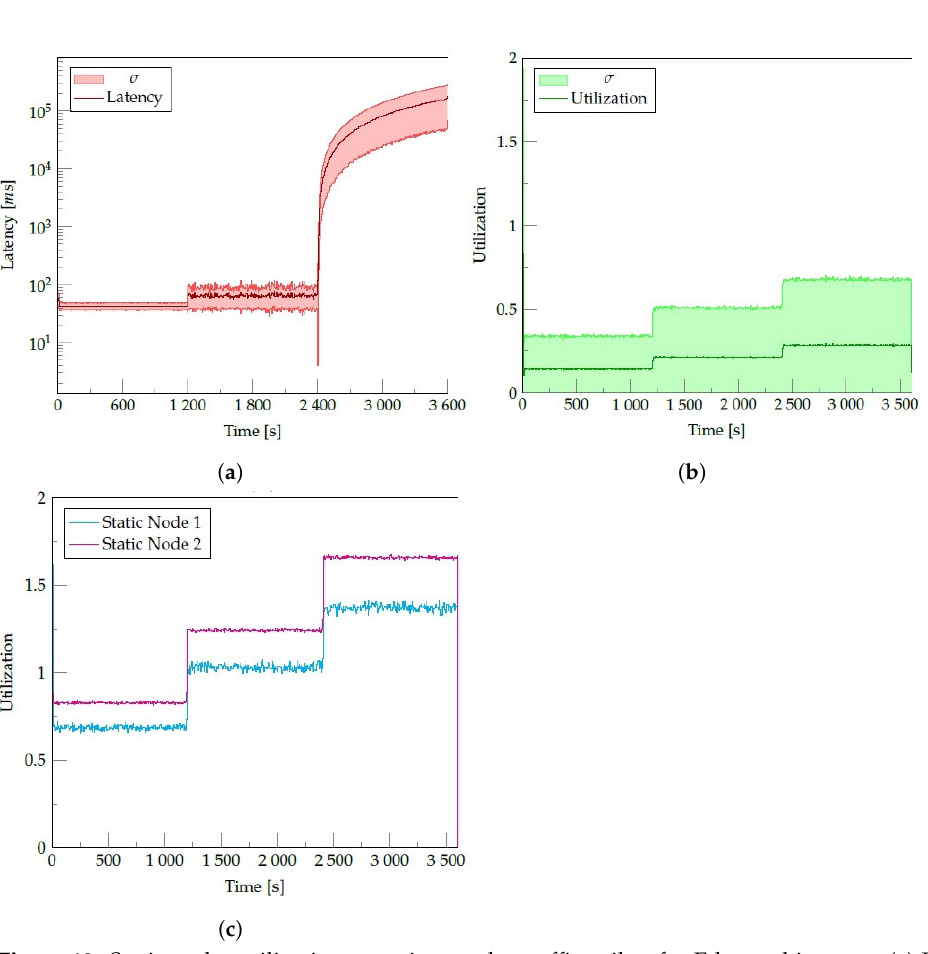
Figure 10. Static nodes utilization over time under traffic spikes for Edge architecture. ( a ) Event Latency. ( b ) Mobile node utilization. ( c ) Static node